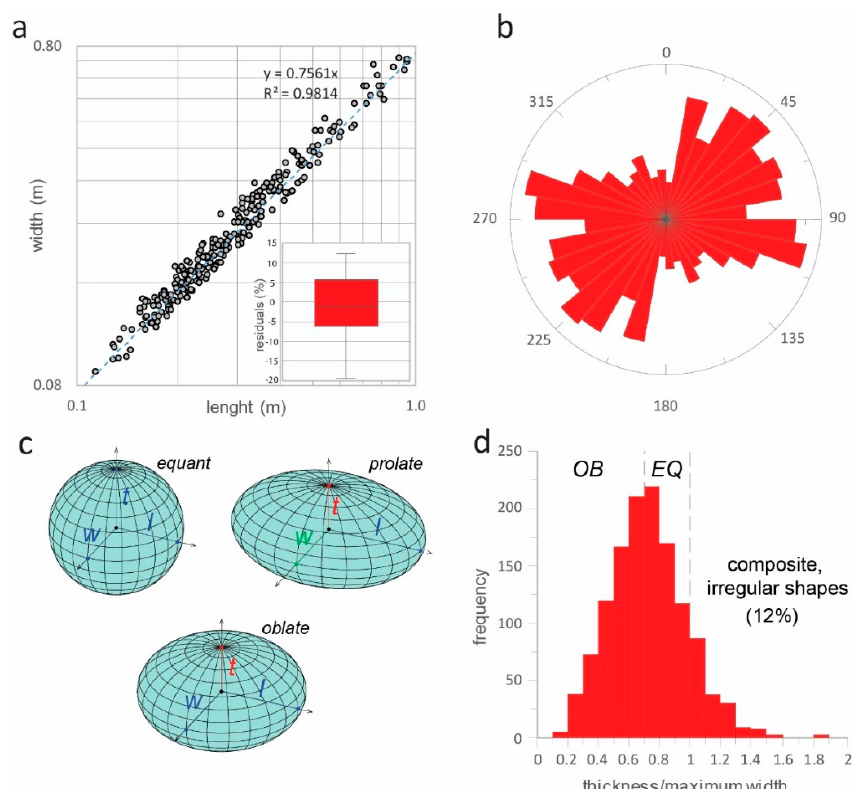
Figure 6. ( a ) Scatter plot (logarithmic axes) of width ( w ) vs. length ( l ) of 269 concretions from the dip ‐ slope parts of the outcrops (see Figure 5c) with linear fit. Note that the coefficient of correlation R 2 indicates a strong positive correlation and normally distributed residuals (as percentage of concretion length in insert box plot); ( b ) Rose diagram showing the azimuth orientation of the lengths (i.e., maximum axes) of concretions resting in the dip slope parts of the outcrop; ( c ) Idealized representation of convex shape classes of Table 1 where l , w and t , denote length (maximum axis), width (intermediate axis) and thickness (minimum axis), respectively; ( d ) Histogram of thickness-to-maximum width ratio of 1315 concretions exposed along steep outcrop faces with t / w threshold values (dashed lines) for oblate (OB), equant (EQ) and composite concretions with t > w (ca. 12% of the population).